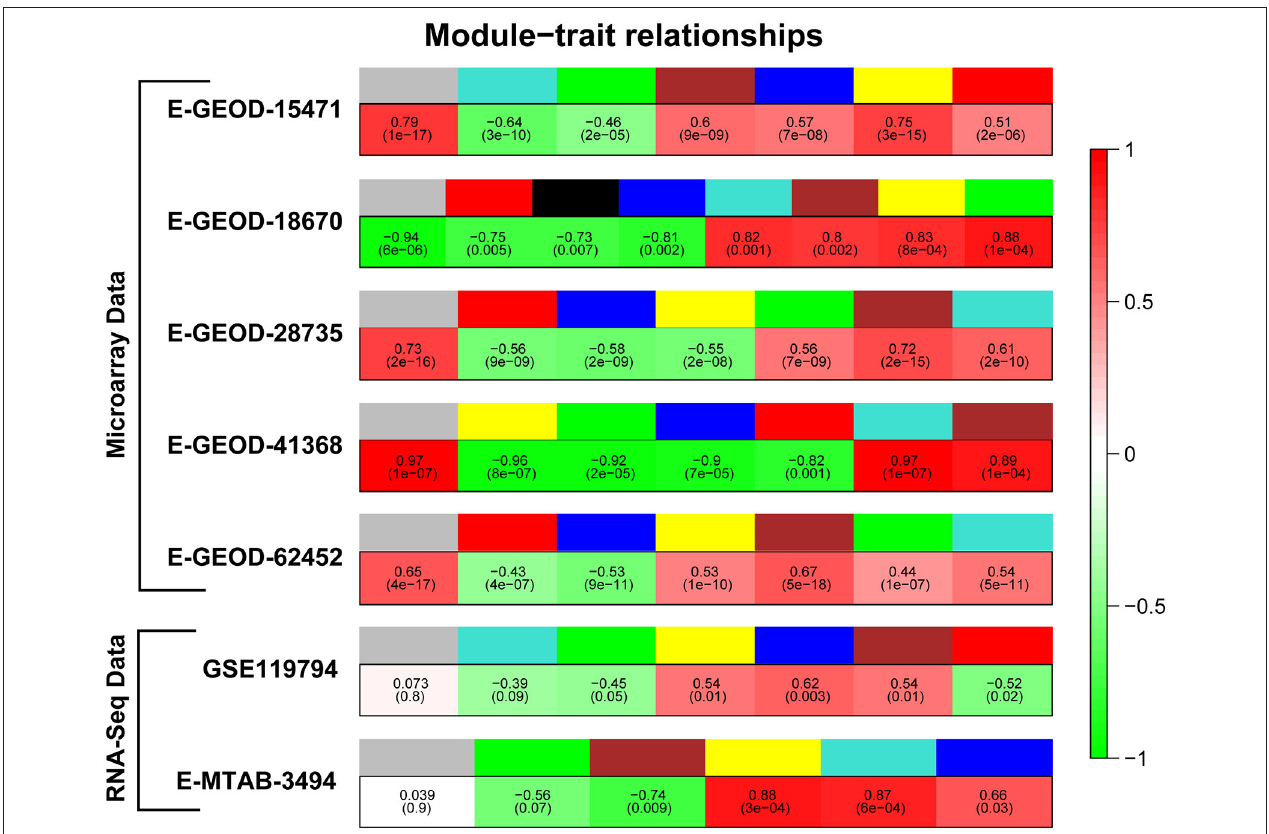
FIGURE 2 | Correlation of modules with pancreatic cancer (PaCa). Figure represents module colors for all datasets and correlation of modules with PaCa phenotype. Colors of modules are given in upper row, whereas green and red colors in lower row represent negative and positive correlation,